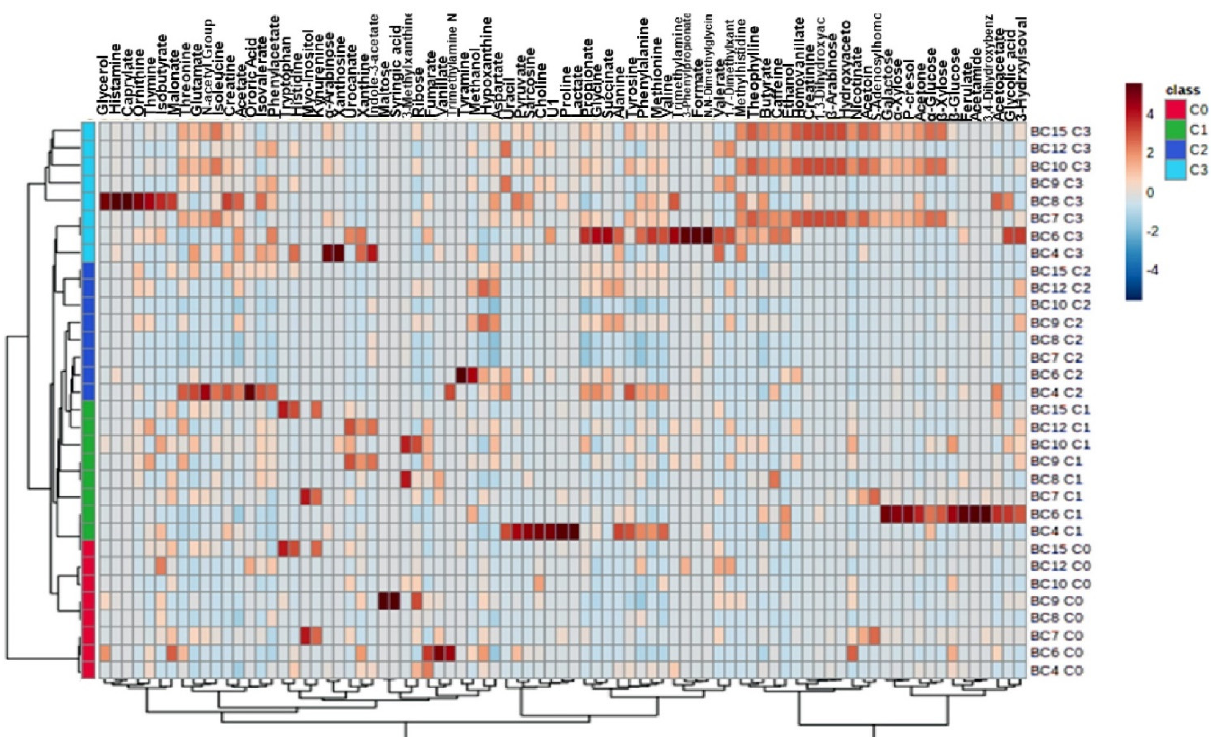
Figure 2. Permutation test plot for the OPLS-DA model (number of permutations, 200; Intercepts: R2 = 0.0, 0.669; Q2 = 0.0, − 0.518).